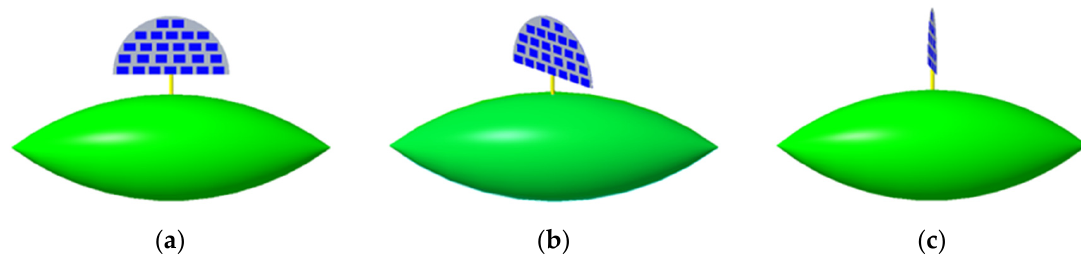
Figure 14. Schematic diagram of solar array rotation angle. ( a ) 0°; ( b ) 45°; ( c ) 90° .